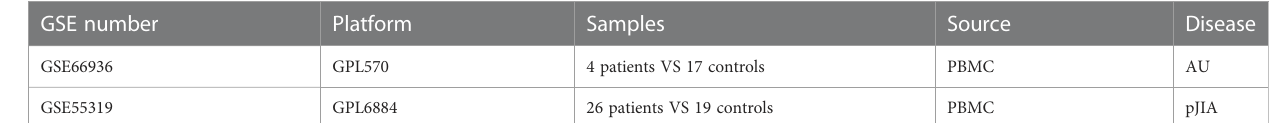
TABLE 1 Information of GEO datasets